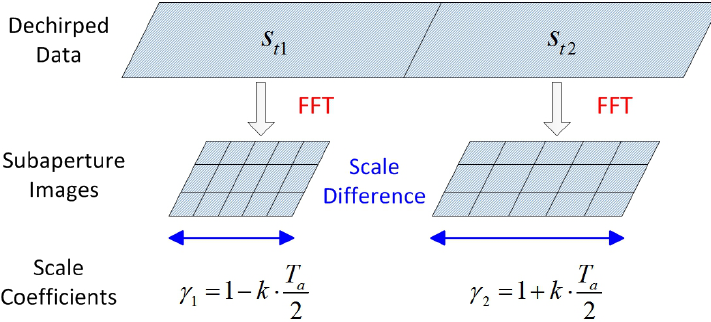
Figure 2. Illustration of scale change between subaperture images. FFT = Fast Fourier